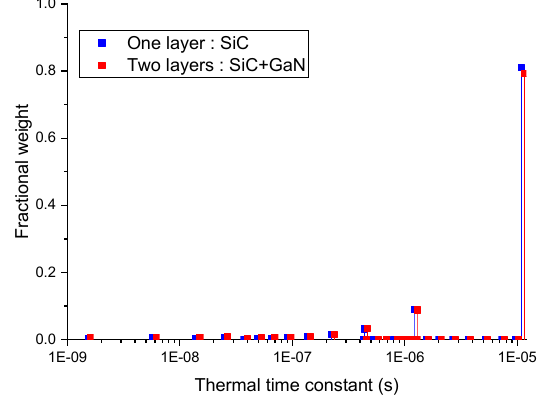
Figure 8. Thermal time constant spectrum for one and two layers. Figure 6 can be considered as one “equivalent” layer structure where: